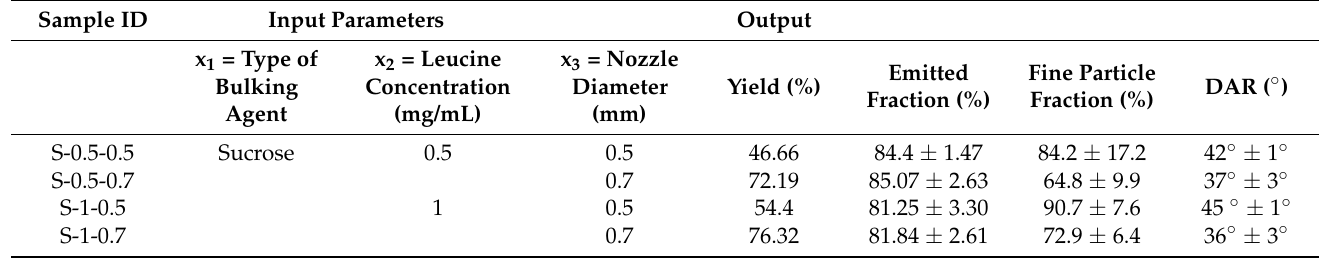
Table 2. Experimental matrix, yield, aerodynamic parameters, and dynamic angle of repose (DAR)